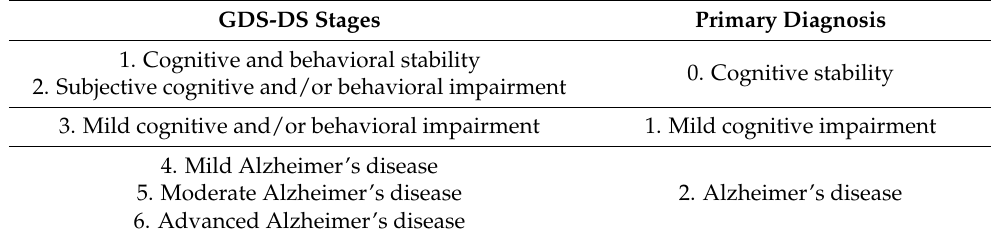
Table 3. Recode numeric